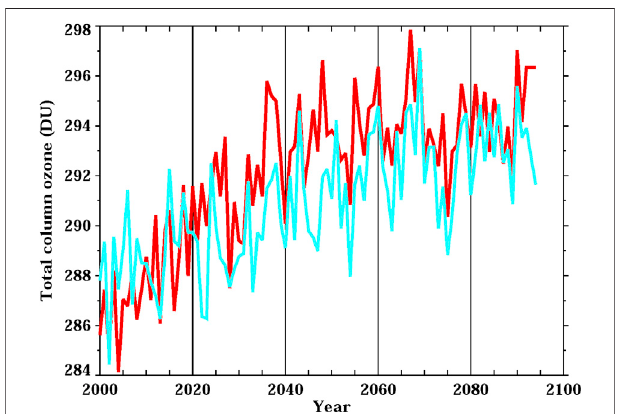
FIGURE 11 | Evolution of the near-global mean TCO obtained from the model SOCOLv4 (red line) and retrieved from proxies with Arosa/Davos TCO as an additional proxy (light blue line). The correlation coef fi cient between reconstruction and the model SOCOLv4 is